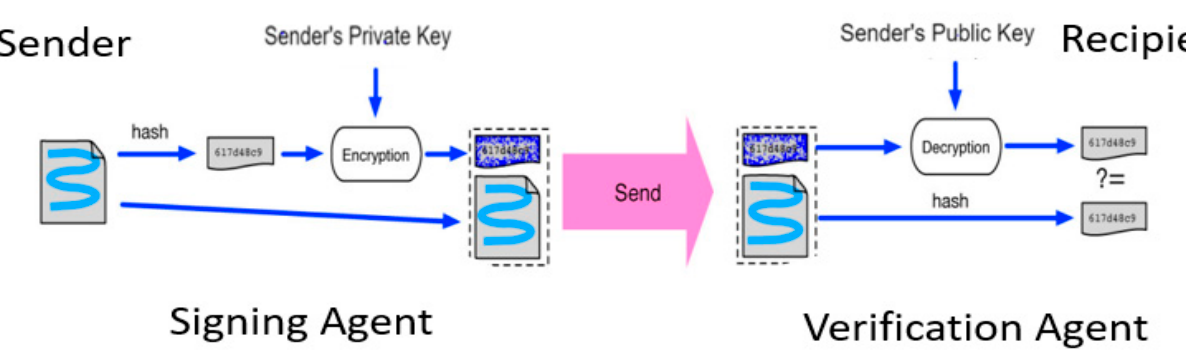
Figure 4. Signing Agent and Verification Agent for Fog Blockchain Manager (FBCM), Core Fog Blockchain Manager (CFBCM) and Cloud Blockchain Manager (CBCM).